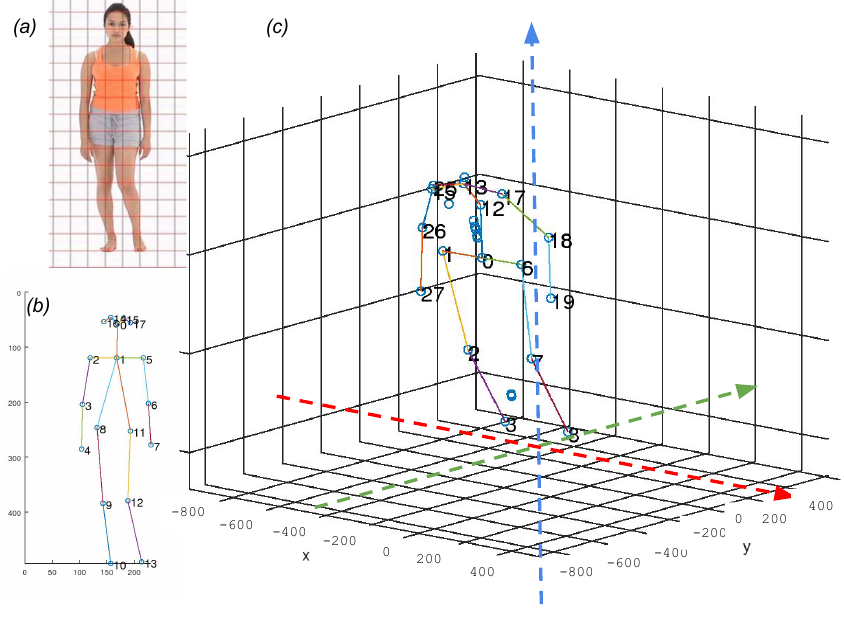
Figure 14. An example of 2D and 3D key joint estimation. ( a ) Input image. ( b ) The 2D estimation result from the input image. ( c ) The 3D estimation from the 2D key joints.